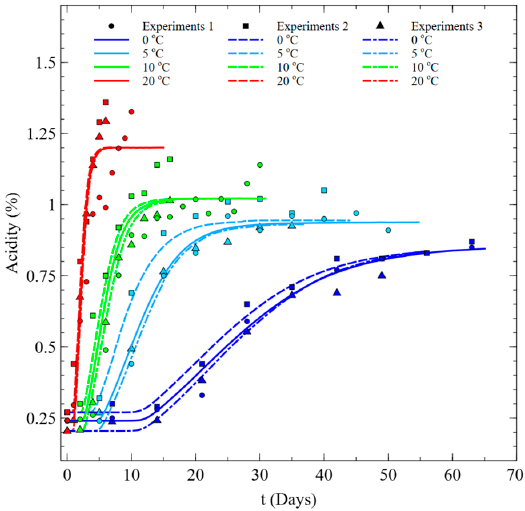
Figure 5. Measured and fitted acidity variation of Kimchi with time under di ff erent fixed temperature conditions. The symbols show the measured data and the lines stand for the fitted data. The di ff erent symbols, i.e., circles, squares, and triangles, and di ff erent line styles, i.e., solid, dashed, dashed dot, are used to represent data from di ff erent batch of experiments. The di ff erent colors categorize di ff erent constant temperature